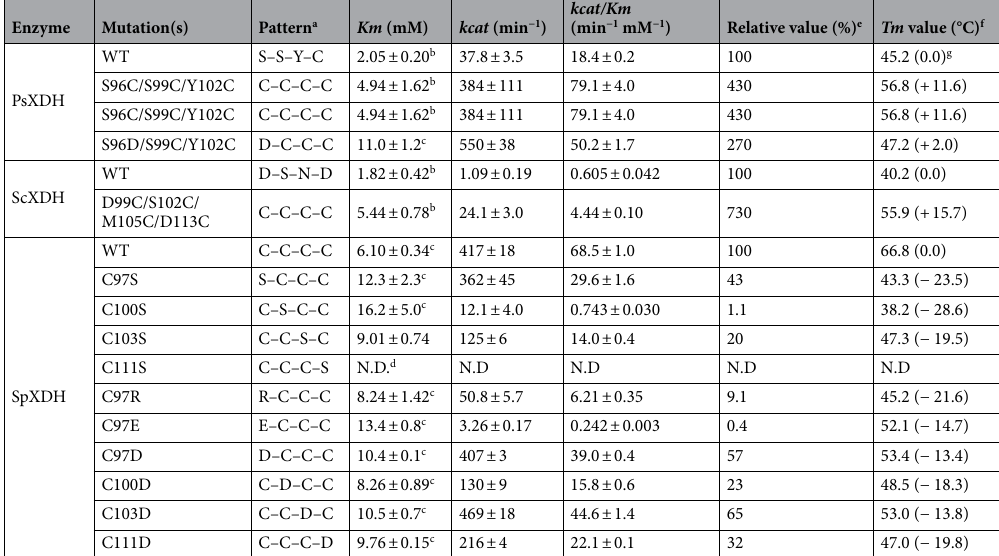
Table 2. Kinetic parameters of WT and mutant XDH enzymes for xylitol. Activity was assayed spectrophotometrically. Values are means ± SD, n = 3. a Four amino acid residues at equivalent positions to Ser96, Ser99, Y102, and Cys110 in PsXDH. b,c Eight different concentrations of xylitol between 0.1 and 1 mM (b) or 1 and 10 mM (c) in the presence of 1.5 mM NAD + were used. d Not assessed due to trace activity. e Relative value of k cat/ K m to each WT. f The apparent half denaturation temperature obtained from Fig. 5 g The difference from each WT enzyme.